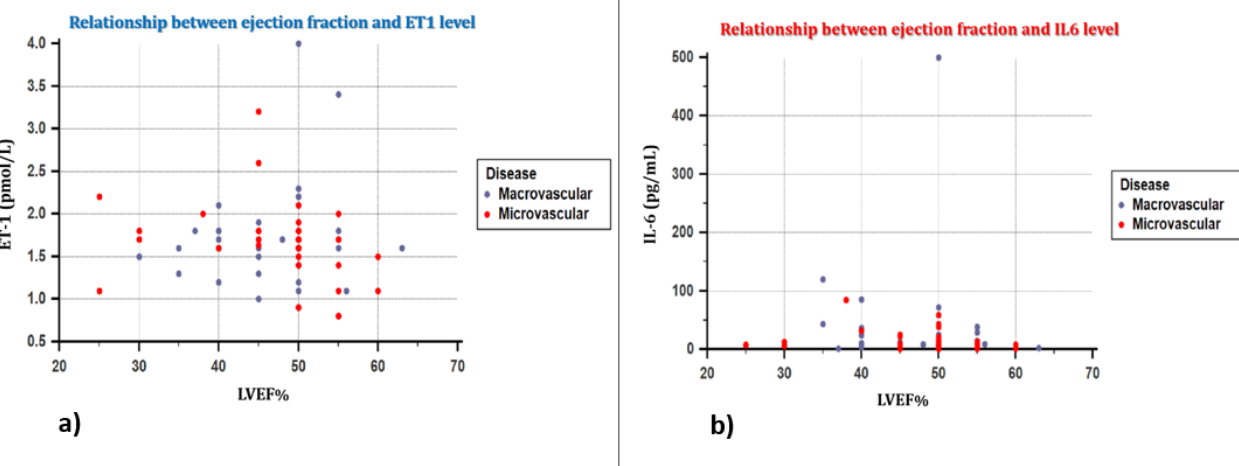
Figure 3. ( a ) Correlation between the ET-1 level and the ejection fraction value in the two groups. ET-1 levels were statistically significantly correlated with LVEF% values in patients with microvascular disease, but not in patients with obstructive coronary heart disease. ( b ) Graphic representation of the correlation between the IL-6 value and the ejection fraction value. Serum IL-6 concentration was not correlated with LVEF%, regardless of the type of coronary heart disease. LVEF%-left ventricular ejection fraction.